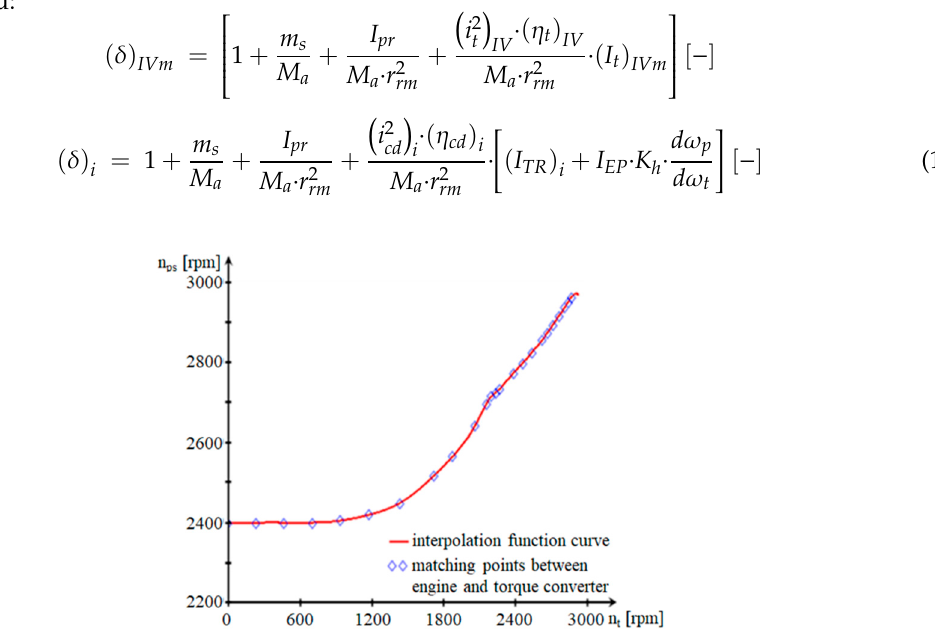
Figure 6 Dependence between pump speed and turbine speed. Figure 6. Dependence between pump speed and turbine